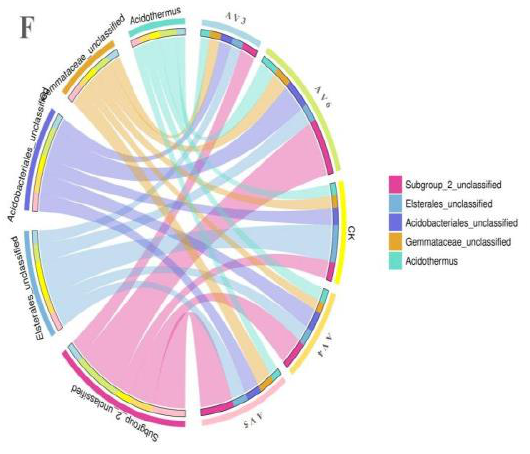
Figure 2. Bacterial composition and community structure in A. villosum rhizosphere soils and a fallow field. ( A ) Bar plot of the bacterial community at the phylum level. ( B ) Circos plot of the top five bacterial communities at the phylum level. ( C ) Bar plot of the bacterial community at the class level. ( D ) Circos plot of the top five bacterial communities at the class level. ( E ) Bar plot of the bacterial community at the genus level. ( F ) Circos plot of the top five bacterial communities at the genus level. The relative abundance in each sample was calculated on the basis of the percentage of the total effective bacterial sequences, which were classified using the SILVA databank. Phyla, classes, and genera representing less than 1% of the total composition in both libraries were classified as ‘other.’ AV3, AV4, AV5, and AV6 represent the rhizosphere soil samples from the fields in which A. villosum was continuously cropped for 3, 4, 5, and 6 years, respectively, whereas CK represents the soil sample from the fallow